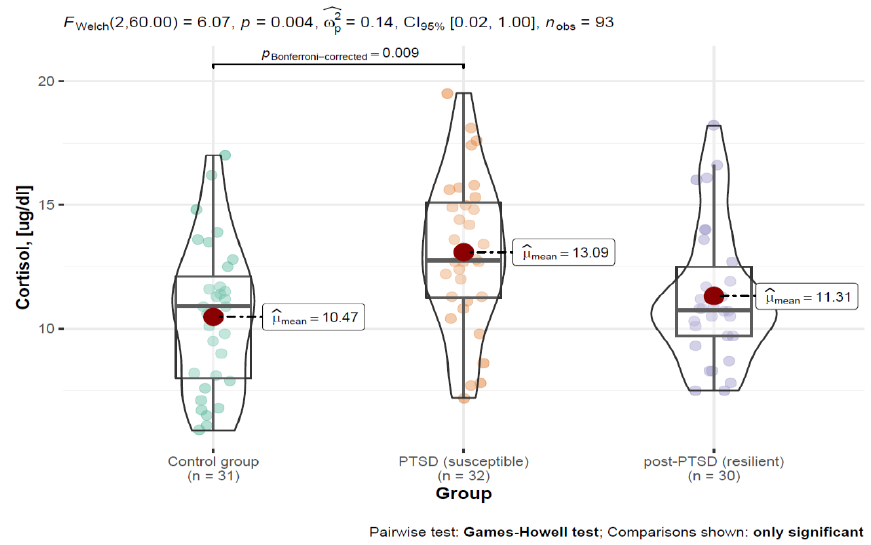
Figure 3. Distribution of the cortisol variable by patient groups in the form of a violin plot, including statistical tests and differences between the